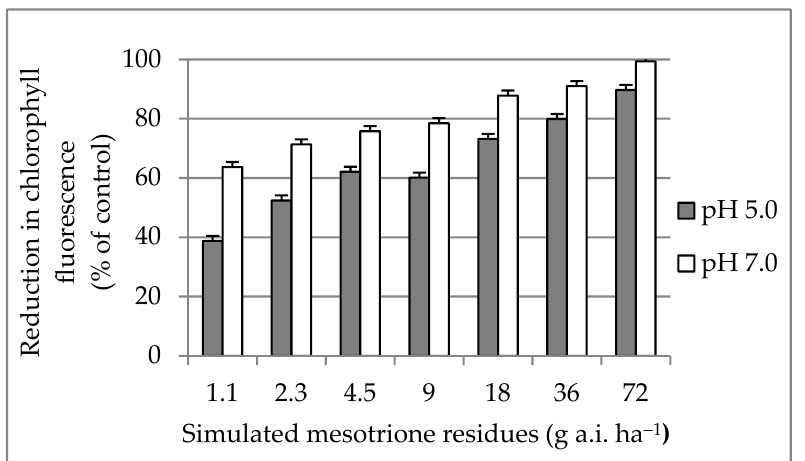
Figure 2. Chlorophyll fluorescence reduction (% of control) in pea plants 35 days after treatment with simulated mesotrione residues applied to soil at pH 7.0 and pH 5.0. Vertical lines indicate a statistical difference according to Fisher’s LSD test at p ≤ 0.05.